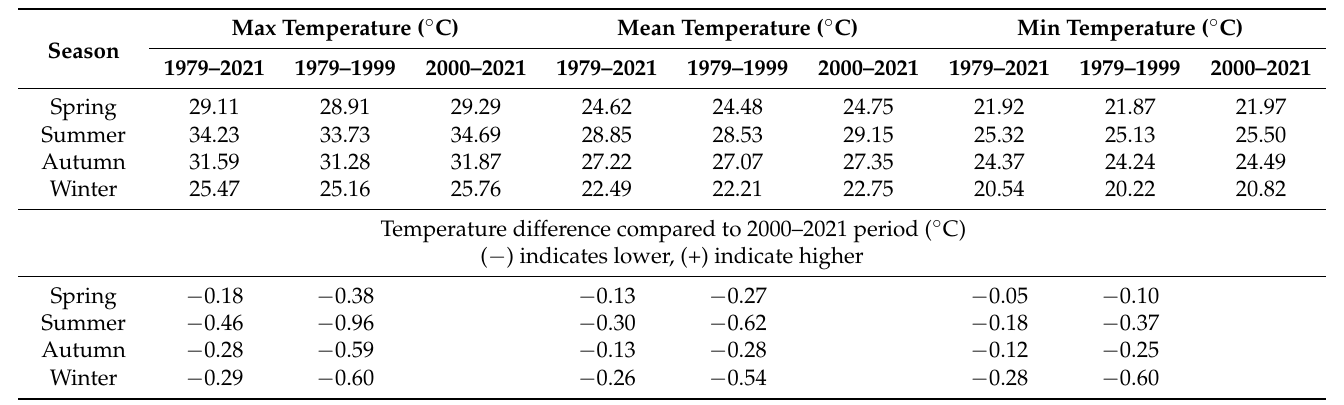
Figure 9. The number of high-temperature days ( ≥ 35 °C) at the Da Nang and Tam Ky meteorological stations. p —statistically significant, R—Decreased/increased rates are the slopes of the linear regression. Table 7. The maximum, minimum, and mean temperatures in different study periods for the Tam Ky meteorological station.